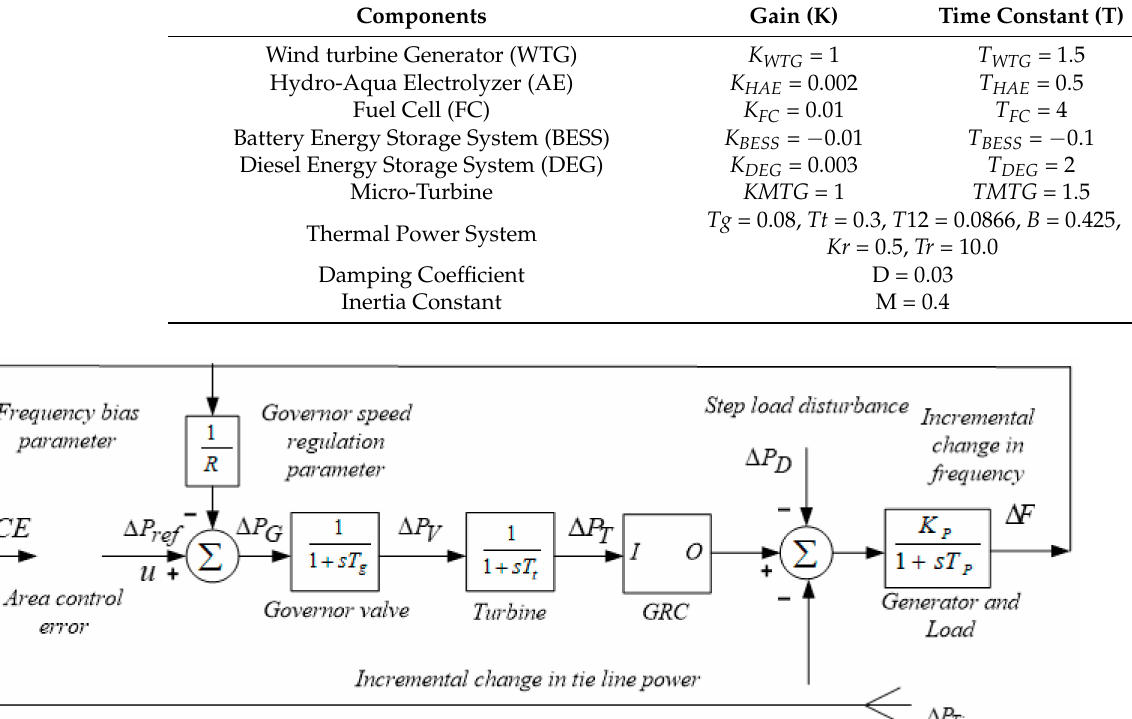
Figure 1. One area of an interconnected power